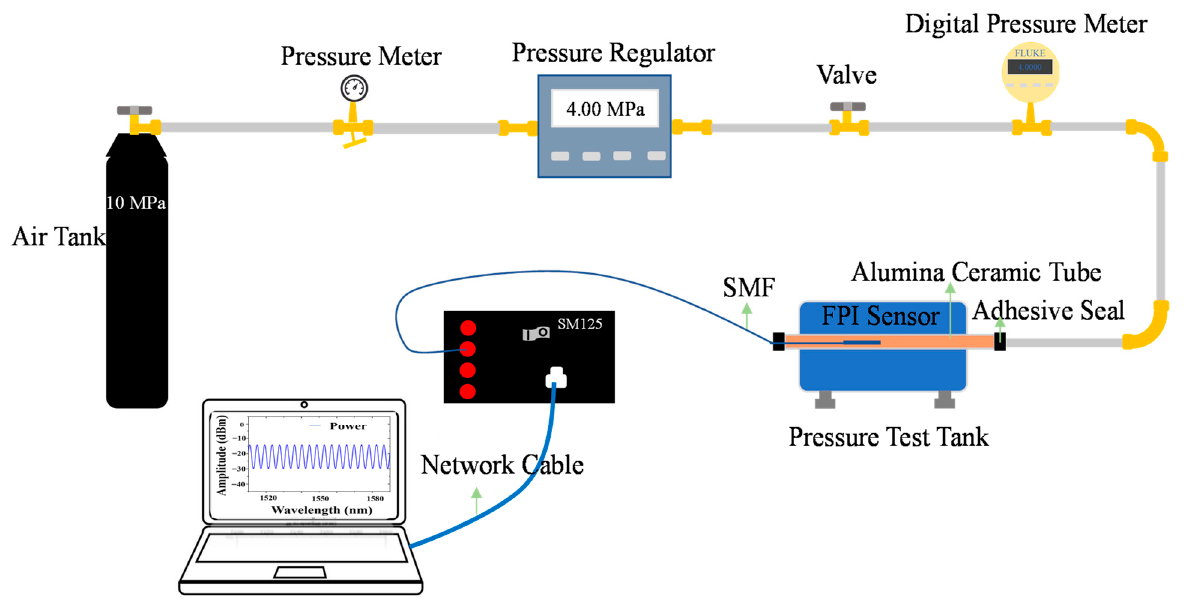
Figure 6. Schematic diagram of the experimental system for the pressure test experiment. The responses of the sensor with rising and dropping pressure were tested for three rounds within a range of 0 to 4 MPa with a step of 0.2 MPa. Figure 7a shows the blue-shift trend of the reflection spectrum as the pressure increased from 0 to 4 MPa, which was due to the compressing of the FP cavity by the increasing external pressure. The response of the resonant wavelength at 1557.81 nm for the three rounds are plotted in Figure 7b. Within the range of 0 to 4 MPa, the sensor manifests good linearity and repeatability.